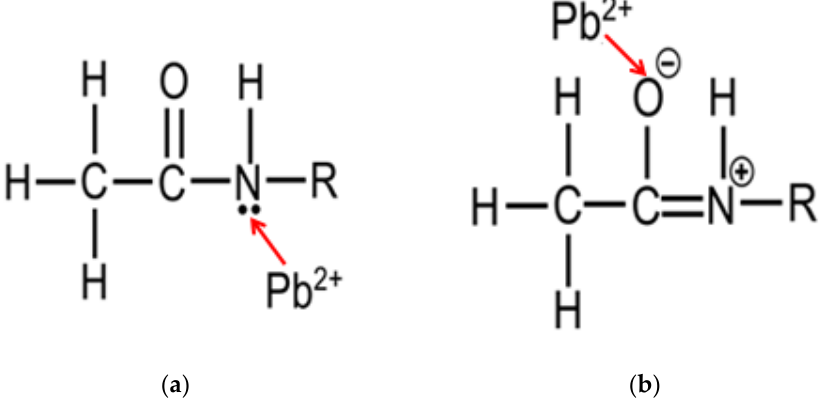
Figure 7. Schematic representation of ( a ) type I and ( b ) type II Pb(II)–amide